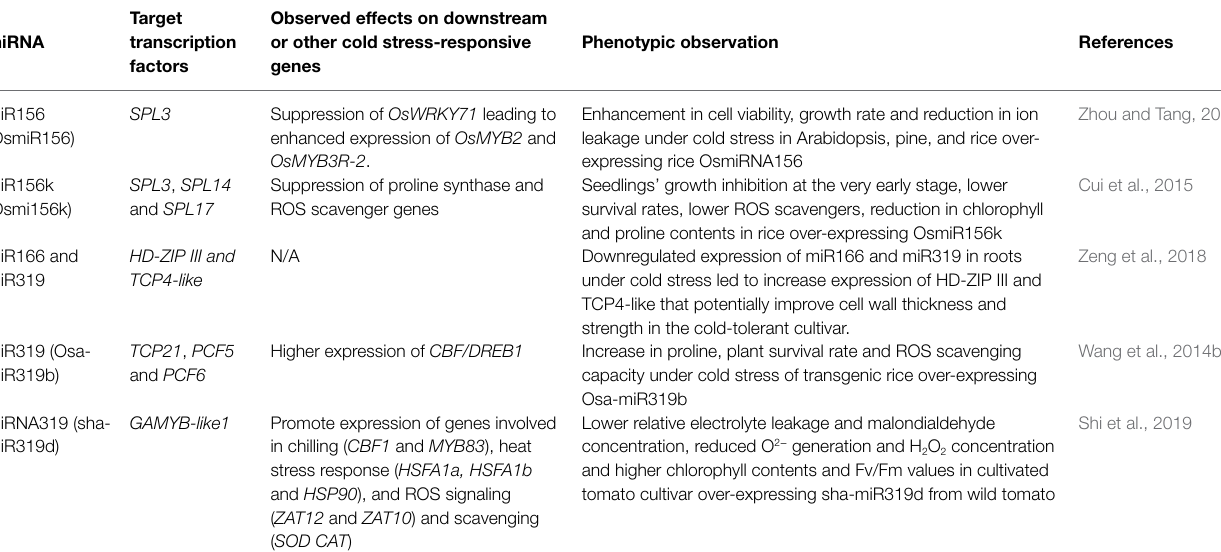
TABLE 2 | Functional studies involving miRNA156, miR166, and miR319. The target transcription factors of the miRNAs, effects on the expression of downstream or cold stress-responsive genes regulated by the transcription factors are provided. The observed phenotypic effects of the miRNA regulation under cold stress are also